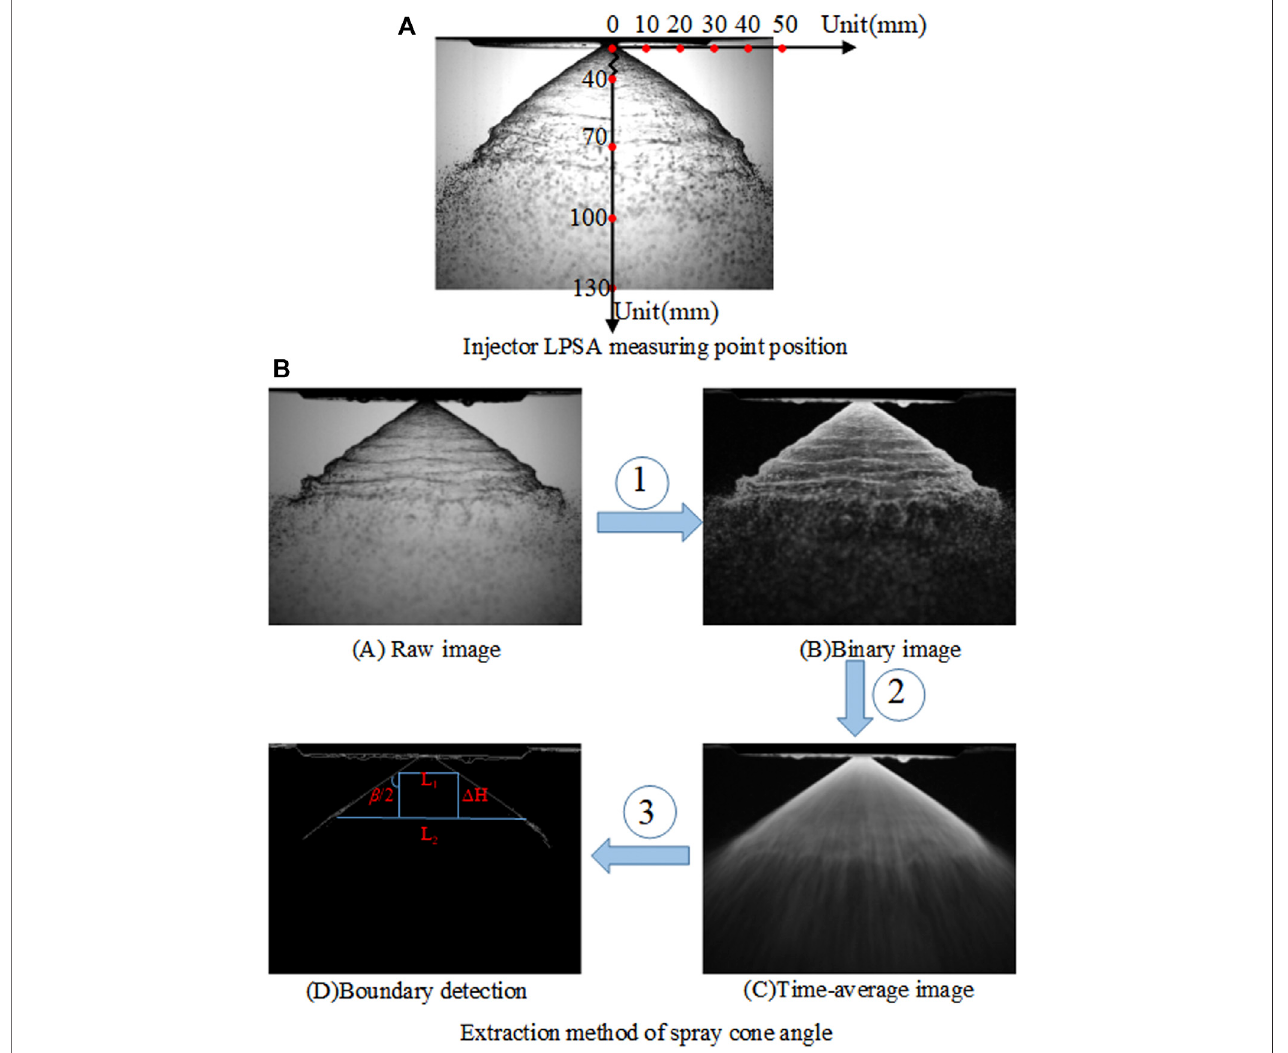
FIGURE 3 | SMD measurement and spray angle extraction